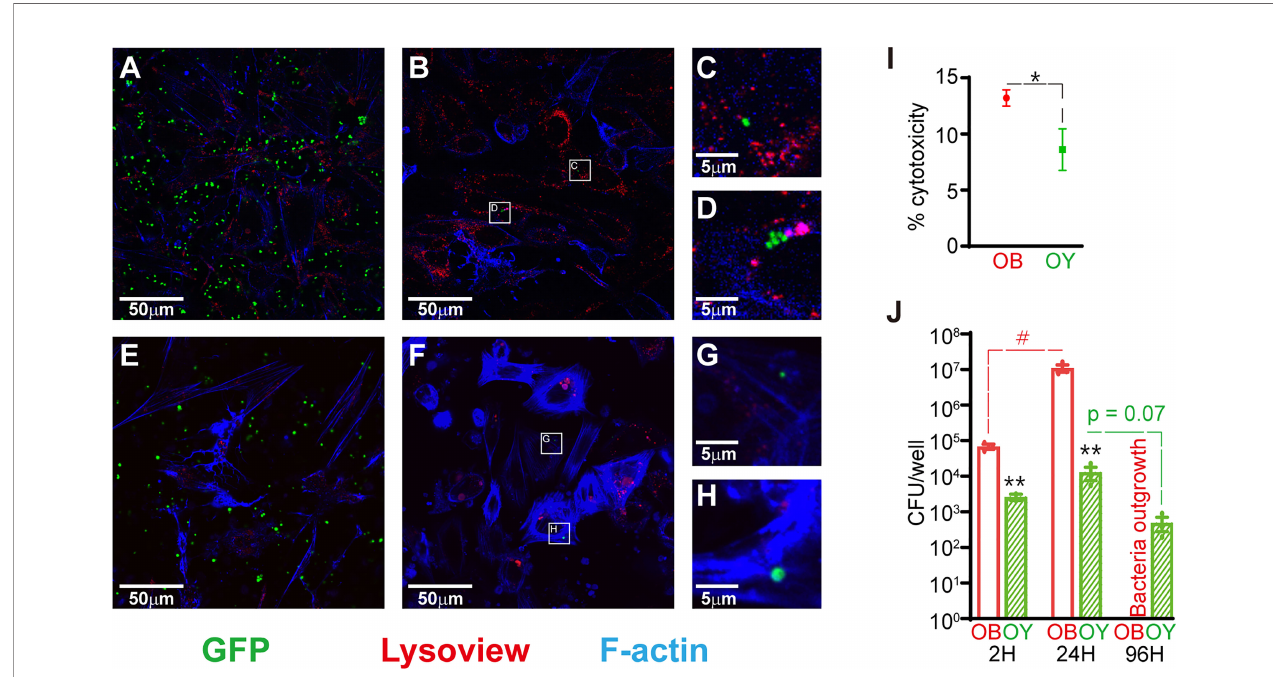
FIGURE 1 | Infection dynamics in SaOS2-OB and SaOS2-OY cells. (A – H) Fluorescent confocal images taken from live samples with the GFP-expressing S. aureus strain RN6390 (green), Lysoview 540 which stains lysosomal bodies (red) and SiR-actin which stains F-actin (blue). Images were taken 2h following inoculation in SaOS2-OB (A) and SaOS2-OY (E) , as well as after 24h in SaOS2-OB (B) and SaOS2-OY (F) . Higher magni fi cation images of intracellular bacteria represented by white squares in (B, F) are shown in (C, D, G, H) , respectively. (I) the % cytotoxicity of 24h of WCH-SK2 infection of either SaOS2-OB or SaOS2-OY was measured using an LDH assay at an MOI of 1. (J) Intracellular infection dynamics were determined using CFU counts recovered from either SaOS2-OB or SaOS2-OY cell lysates infected with WCH-SK2 (MOI of 1). The cells were cultured within antibiotic-free media following 2h of lysostaphin treatment immediately post-infection to kill bacteria that failed to invade into the intracellular niche. Data shown are means of biological triplicates ± standard error of the mean. Signi fi cant differences between cell types are indicated by * p < 0.05 and ** p < 0.01, respectively. Signi fi cant change as a function of time is indicated by # p <